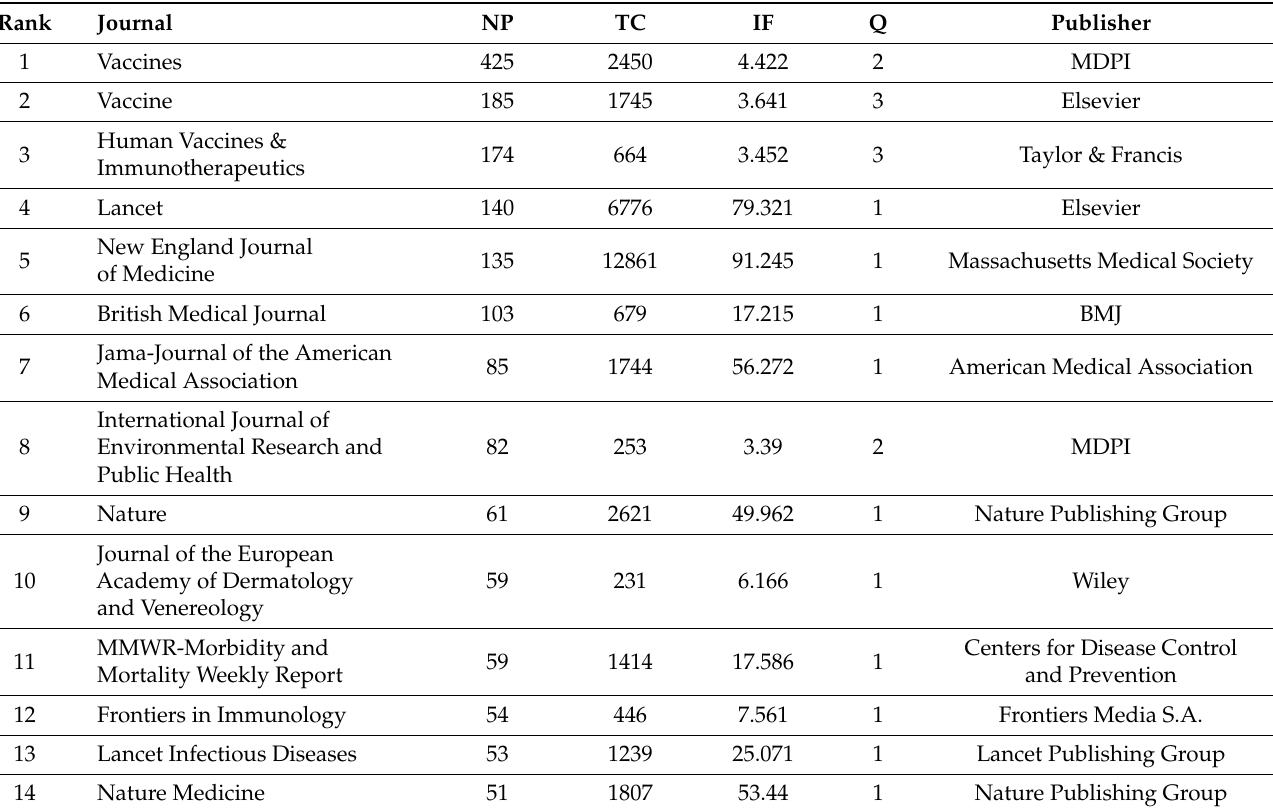
Table 4. The most prolific journals in COVID-19 vaccine research. (IF: Impact factor, Q: Quarterly journal).